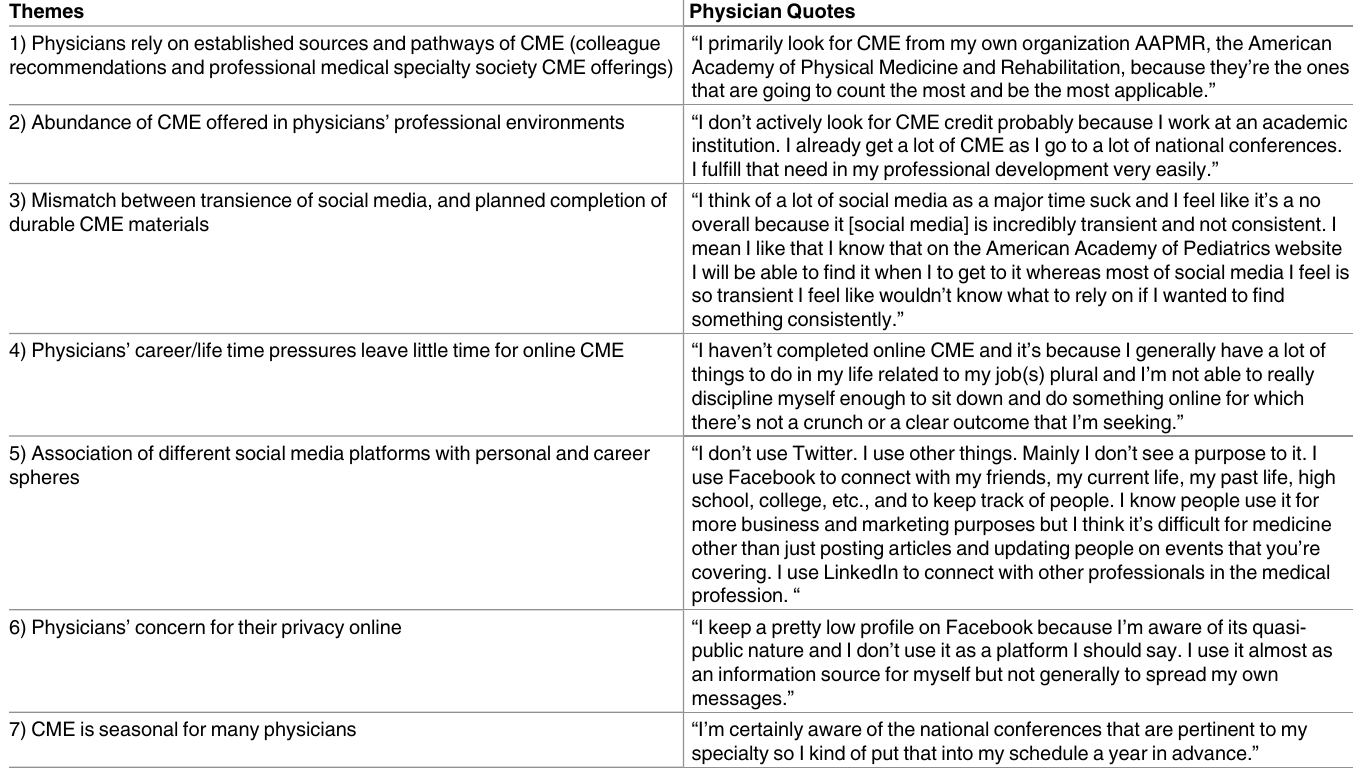
Table 3. Example Quotes from Interviews with